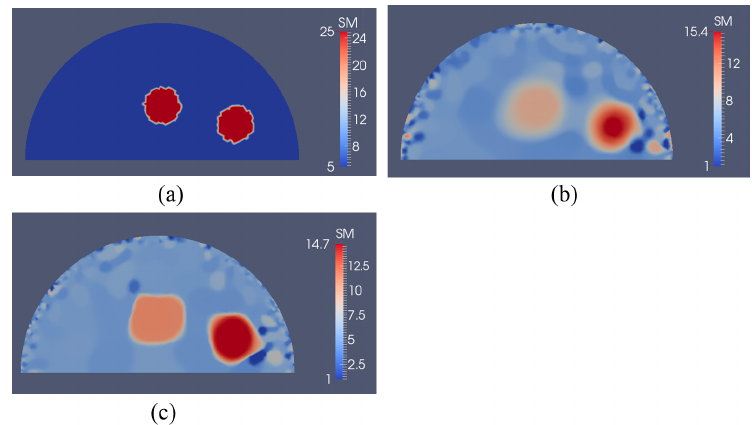
Figure 17. Shear modulus reconstructions with 1% noise. ( a ) target shear modulus distribution for comparison; ( b , c ) reconstructed shear modulus distribution using 5 and 10 boundary displacement data sets, respectively (unit in the scale bar: kPa). Note: “SM” stands for shear modulus.